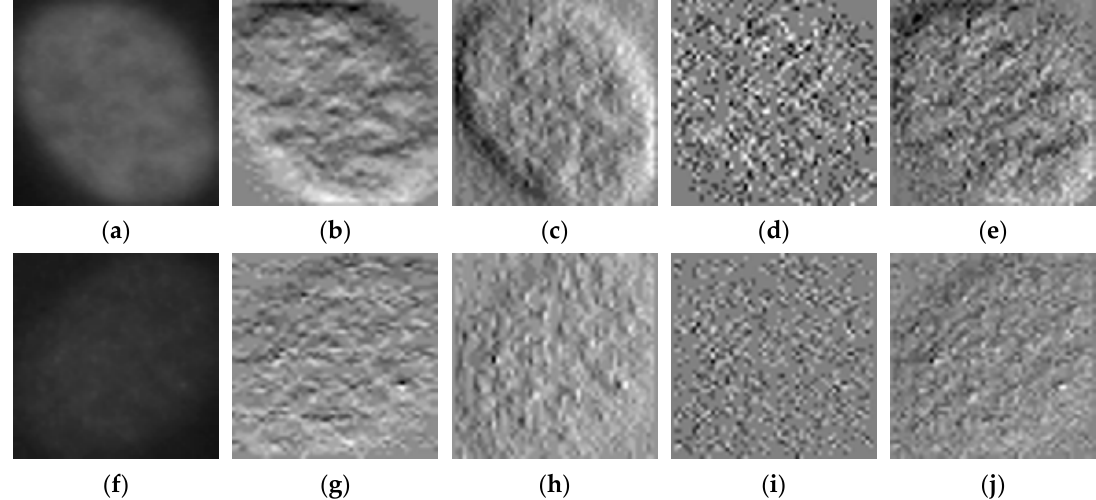
Figure 4. HEp-2 cellular images from the SNPHEp-2 dataset. ( a ) A positive intensity homogeneous cell and ( b – e ) its horizontal, vertical, diagonal details and their sum, respectively. ( f ) A negative intensity homogeneous cell and ( g – j ) its horizontal, vertical, diagonal details and their sum, respectively. The original images in ( a , f ) have a size of 112 × 112. Their respective detail coefficients in ( b – e ) and ( g – j ) are all downsized by half (56 × 56). All the images in the figure were identically resized for the purpose of visualization.